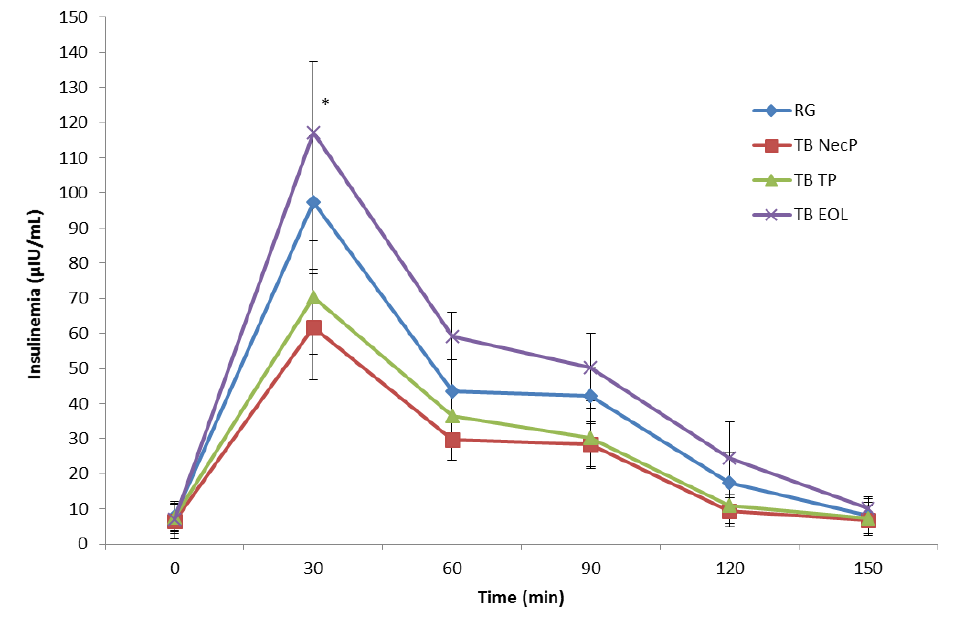
Figure 2. Change in postprandial plasma insulin concentration in healthy adults for the three treatment beverages. TB NecP (2 g of NecP, equivalent to 14 µg ABA); TB EOL (400 mg EOL, equivalent to 60.0 mg oleuropein); TB TP (2 g TP, equivalent to 1.0 mg total carotenoids). Data are mean ± SD. * Indicates a significant difference between peak 30 min insulin concentration for each treatment test compared to the reference test ( p < 0.05). Abbreviations: RG, regular glucose solution;